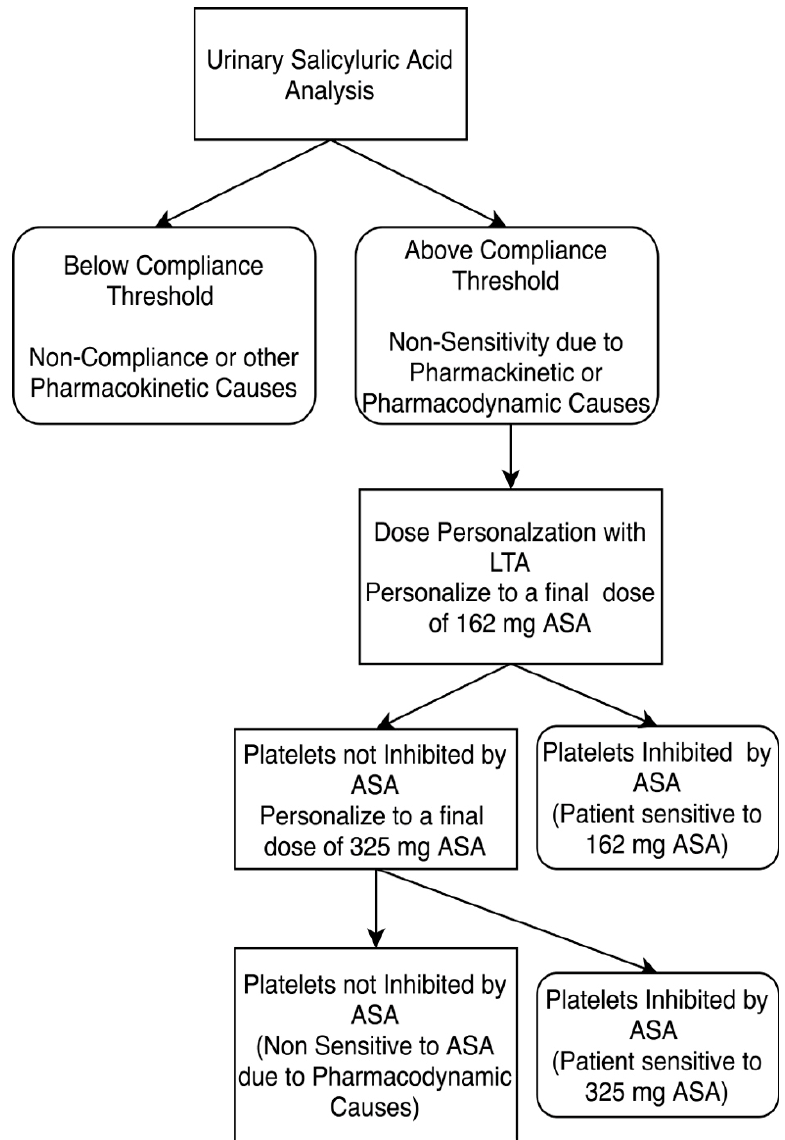
Figure 2. Study design for personalizing aspirin therapy in 81mg ASA compliant patients. Patients who were non-sensitive to 81 mg ASA therapy underwent ASA dose personalization at final doses equivalent to 162 and 325 mg ASA. Platelets were considered not inhibited by ASA if there was evidence of ≥ 20% maximal platelet aggregation during LTA analysis after activation with arachidonic acid. ASA compliance was defined as urinary salicyluric acid levels >27 µM.